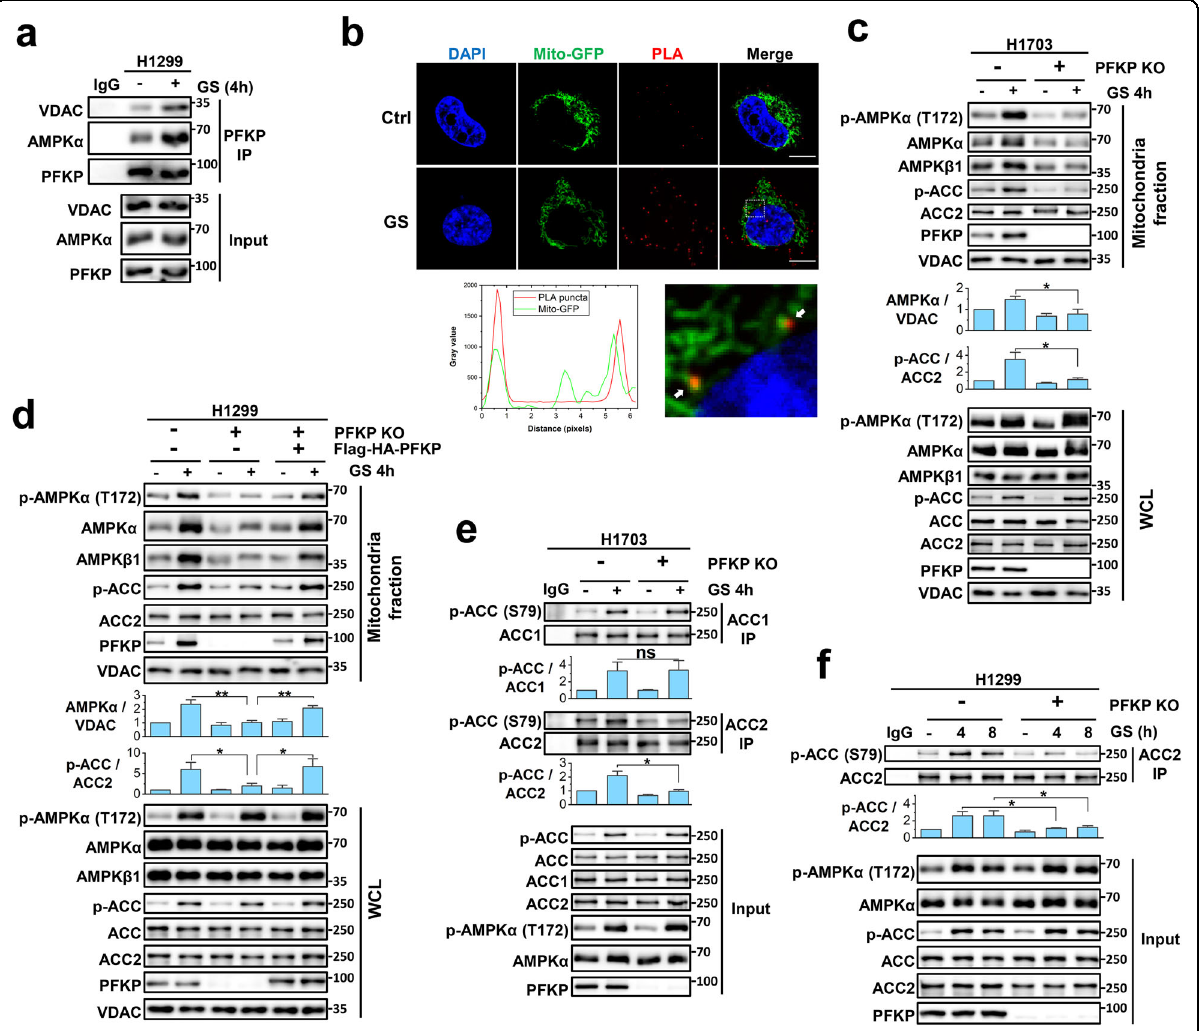
Fig. 4 PFKP promotes mitochondrial recruitment of AMPK and enhances the phosphorylation of ACC2. a PFKP IP in H1299 cells under control or GS. b Immuno fl uorescence analysis of mito-GFP and PLA puncta (interacted PFKP and AMPK) in H1299 cells under control (Ctrl) or GS for 4 h. The gray values of green and red signals between two the arrows were plotted. Scale bar, 10 μ m. c , d Mitochondria fraction analysis of H1703 ( c ) and H1299 ( d ) cells under control or GS. e IP of ACC1 and ACC2 in H1703 cells under control or GS. f ACC2 IP in H1299 cells under control or treated with GS for 4 h or 8 h. Data are shown as means ± SD with three biological replicates. ns, no signi fi cance; * P < 0.05, ** P < 0.01, *** P < 0.001 by two-tailed Student ’ s t